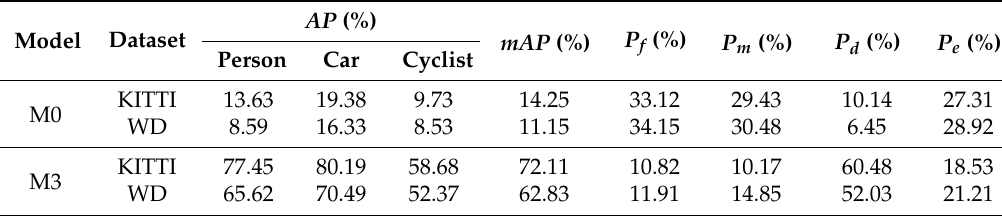
Table 3. Low-resolution small object detection effect